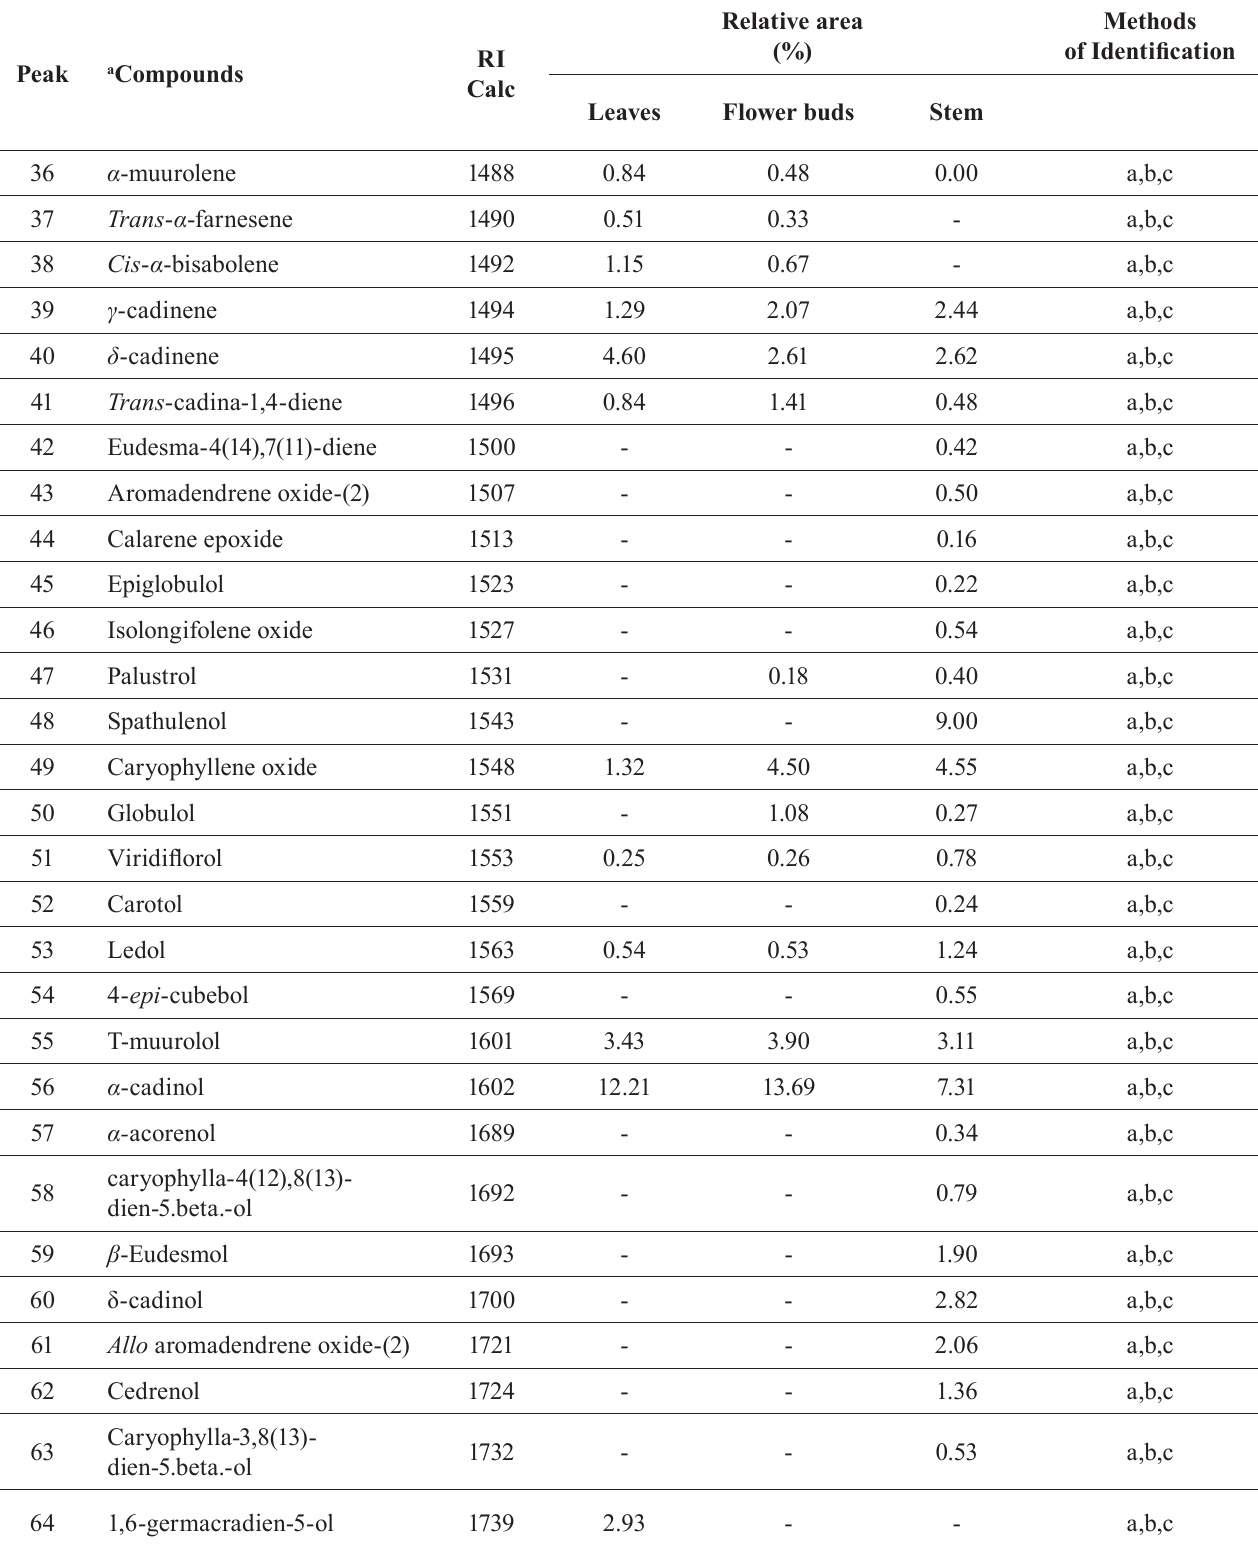
Relative area Methods RI